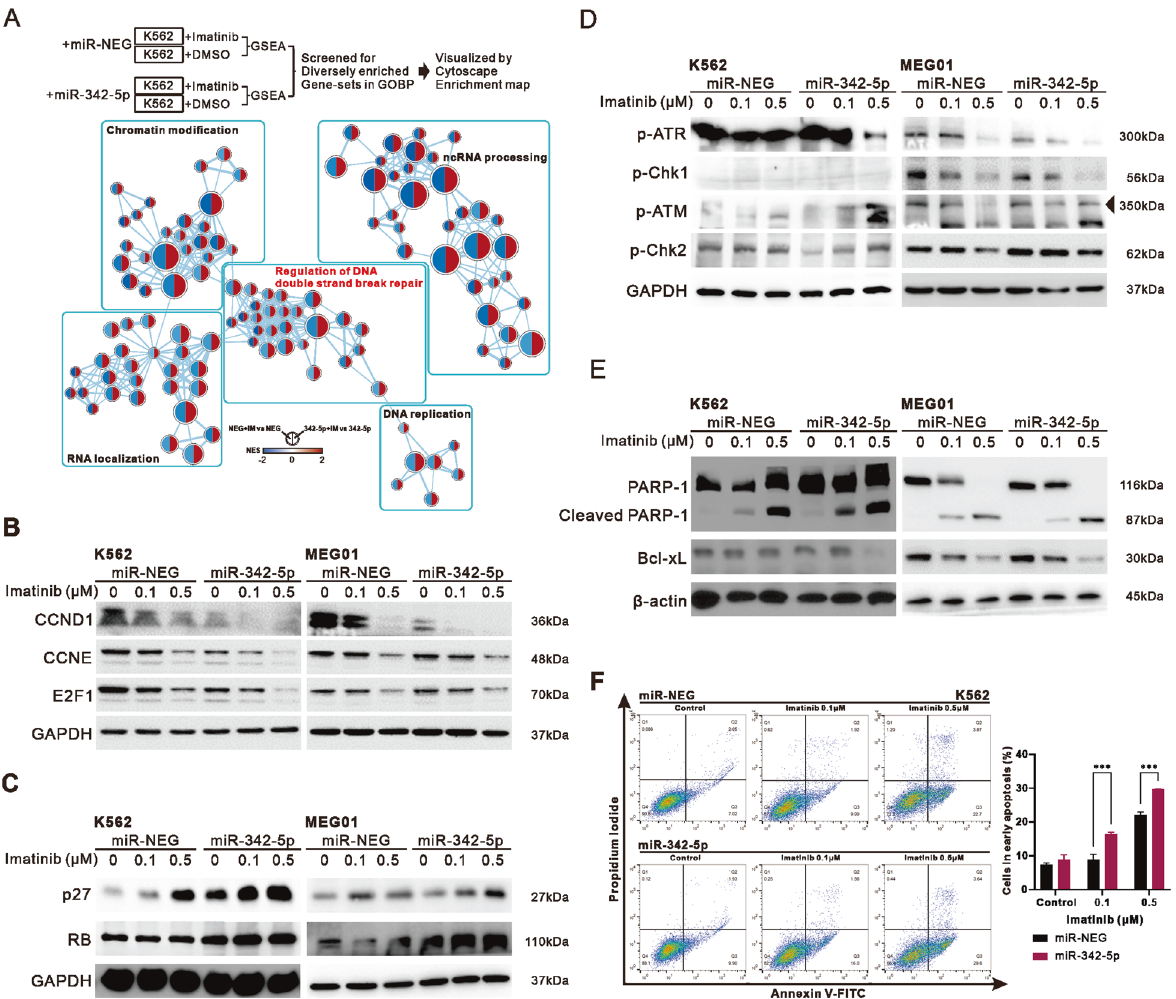
Fig. 5 Increased double-stranded DNA breakage response and apoptosis may be a potential mechanism for miR-342-5p inhibition of CML. A The enrichment map presented divergent trends of GSEA enrichment with the treatment of 0.5 μ M imatinib in miR-NEG or miR-342-5p expression. The width of the edge connected between nodes represents the degree of overlap, and similar nodes are auto-annotated as clusters. GSEA enrichment fi ltering criteria: P < 0.05, FDR < 0.25. B – E Western blot presents the expression of cell cycle components including CCND1 (B), Cell cycle regulating proteins ( C ), DNA repair components including ATM-chk2 and ATR-chk1 axis ( D ), and apoptosis-associated proteins ( E ) in K562 and MEG01 subjected to imatinib under miR-NEG or miR-342-5p expression (20 nM). F Validation of the effect of miR-342- 5p on apoptosis in K562 caused by imatinib in the presence of miR-342-5p (20 nM) by Annexin-V/PI method using fl ow cytometry. The bar chart shows the difference in the percentage of cells at early apoptosis under duplication. The student ’ s t -test or One-way ANOVA approach was used to assess the signi fi cance. * P < 0.05; ** P < 0.01; *** P < observation was made in the miR-342-5p side in the same mice (Fig. 6B). Paired comparison of CML cell viability in MTAM from the same animal (left: miR-NEG, right: miR-342-5p) showed lower viability of K562 with miR-342-5p expression and a statistically signi fi cant difference in the group receiving imatinib (Fig. 6C). Furthermore, in the combined comparison, the viability of CML cells expressing miR-342-5p was signi fi cantly reduced compared to miR-NEG (Fig. 6D, lane 1 vs. 2). This effect was not and GSE144119 were obtained from the PBMC of the patients ’ signi fi cant compared to the group with imatinib treatment blood samples, which were the same as our clinical samples. alone (lane 2 vs. 3), suggesting that miR-342-5p expression GSE4170 was obtained from CD34 + cells, and GSE13204 was already exerted an inhibitory effect on K562. Expression of miR- 342-5p signi fi cantly increased the inhibitory effect of imatinib obtained from the bone marrow of CML patients. Firstly, we on K562 compared to the group receiving concomitant imatinib con fi rmed the association between miR-342-5p expression and (lane 3 vs. 4). In addition, the group treated with miR-342-5p CML progression in GSE144119, showing that miR-342-5p expres- and imatinib together signi fi cantly inhibited the growth of K562 sion was signi fi cantly lower in PBMC from CML patients in the compared to miR-NEG (lane 1 vs. 4). These results suggest that chronic phase (Fig. 7A). Secondly, we con fi rmed the association of loss of miR-342-5p affect the ability of imatinib to inhibit CML miR-342-5p expression with CCND1, BCR and ABL1 expression. proliferation in vivo. Heat map showed that the distribution of miR-342-5p was